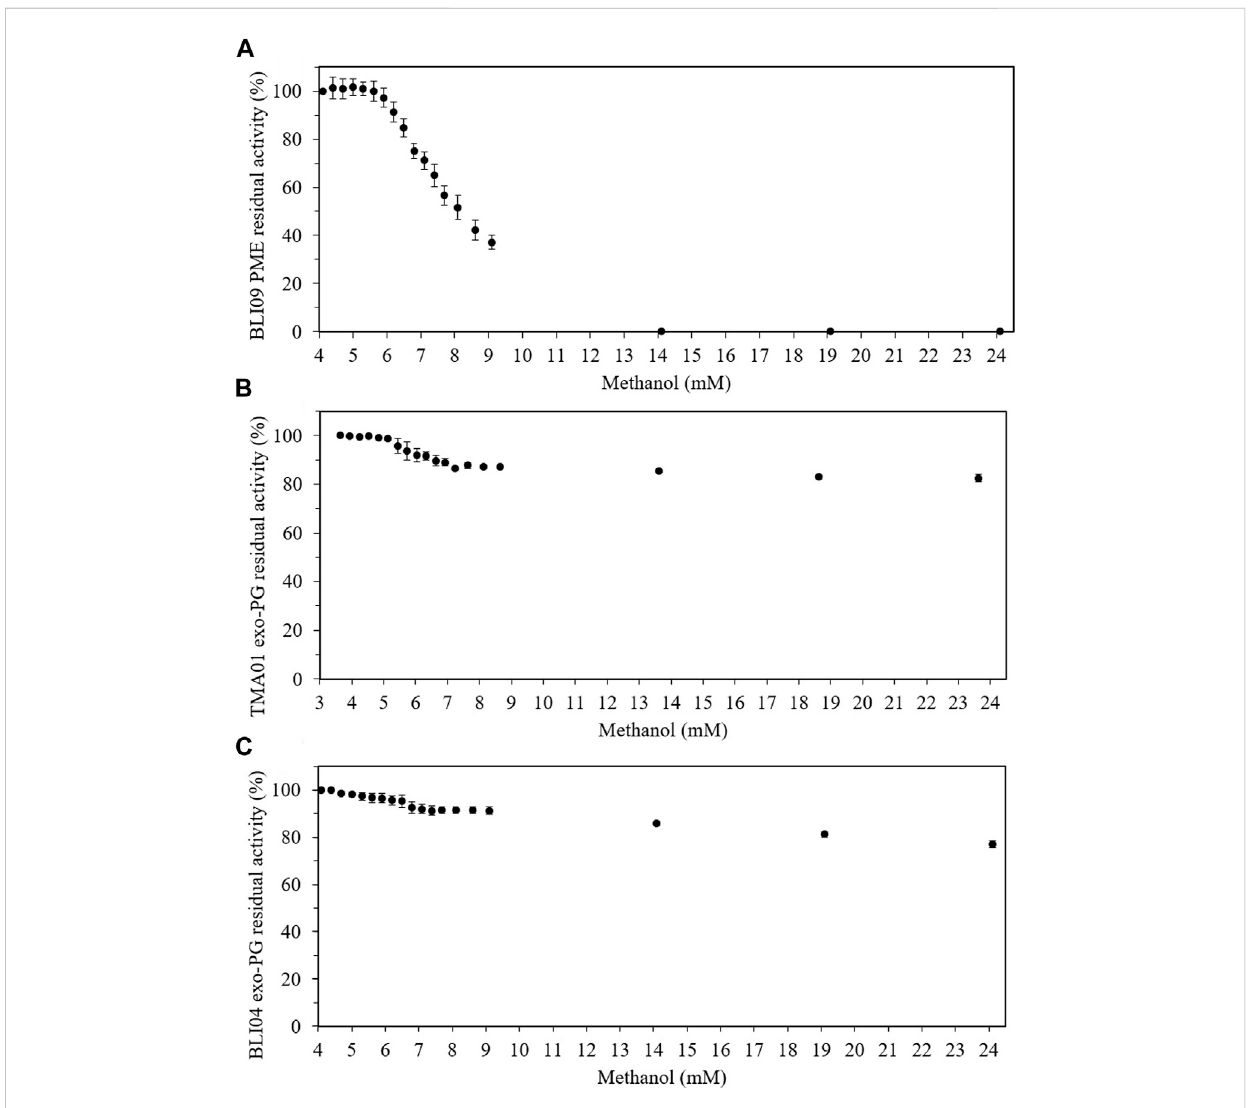
FIGURE 5 Product inhibition effect of methanol on pectinases from co-expression constructs 3 and 4. (A) Methanol effect on BLI09, (B) TMA01 and (C) BLI04. The reactions were carried out at 50 ° C and 300 rpm for 30 min using 0.5% (w/v) apple pectin (in 20 mM phosphate pH 7), and 0.5 and 2 U mL − 1 of TMA01andBLI04,respectively. TheBLI09activitywascalculatedinthevolumecontainingtheUmL − 1 ofTMA01mentionedbefore(SupplementaryTable S3). Error bars represent one standard deviation from the mean (n = 2). PME: pectin methylesterase, exo-PG: